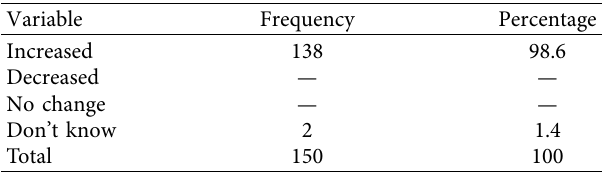
Table 1: Perceptions of the respondents on change in temperature over the years.